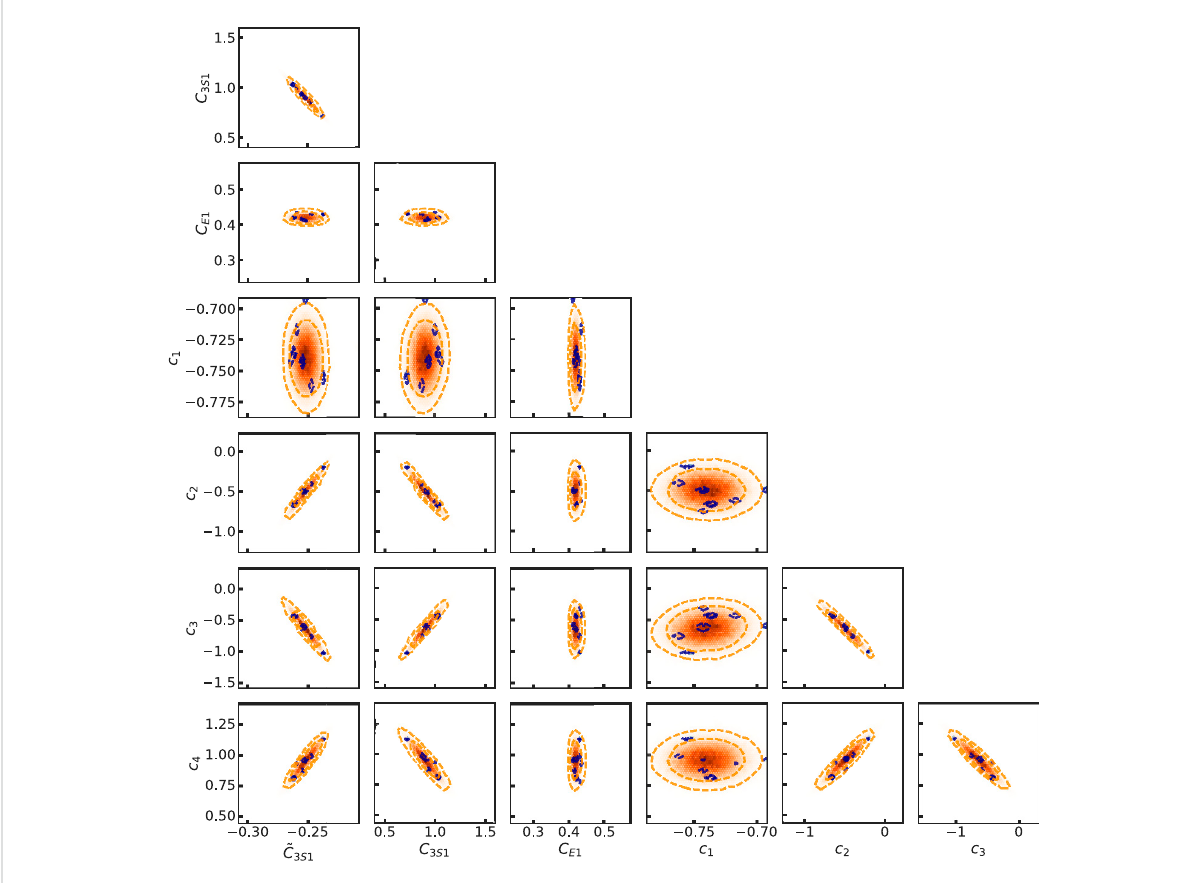
FIGURE 5 The posterior of LECs sampled with S/IR (blue) compared with MCMC sampling (orange) for a situation when the deuteron calibration observables are associated with errors that have been reduced by an order of magnitude (see text for details). The LECs are shown in units